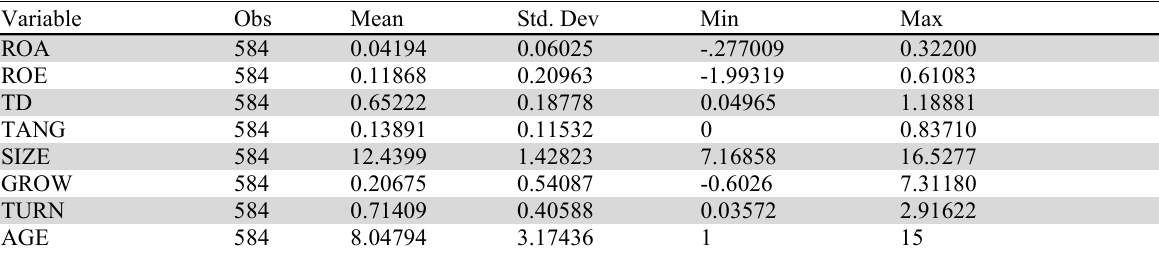
Descriptive statistics of variables in the model